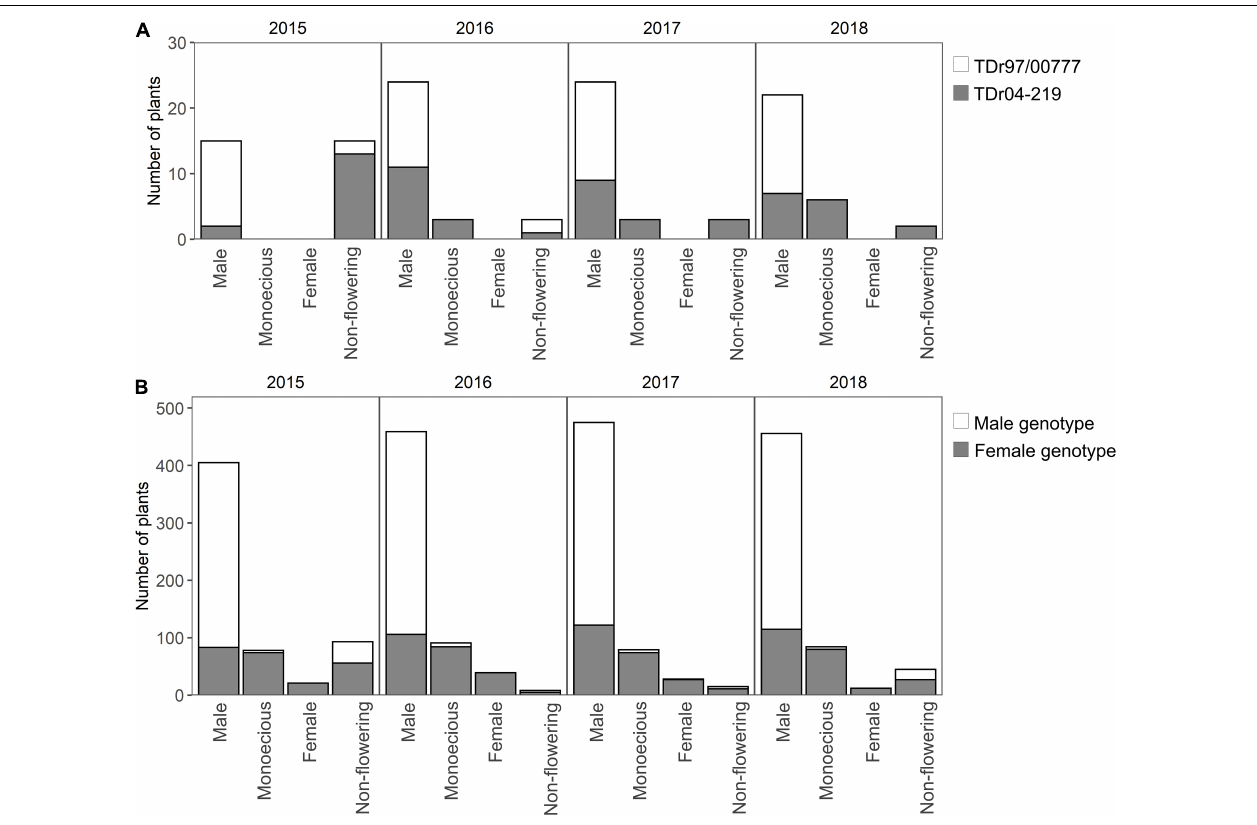
FIGURE 3 | Distribution of sex phenotype in the parental plants and the cross population. The number of plants in each of the sex phenotype is separately shown for sex genotypes. (A) Sex phenotype distribution in the parents. A total of 15 samples were taken for each parent. (B) Sex phenotype distribution in the F 1 population. The total numbers of plants of male and female genotypes were 363 (121 accessions × 3 replications) and 234 (78 accessions × 3 replications),